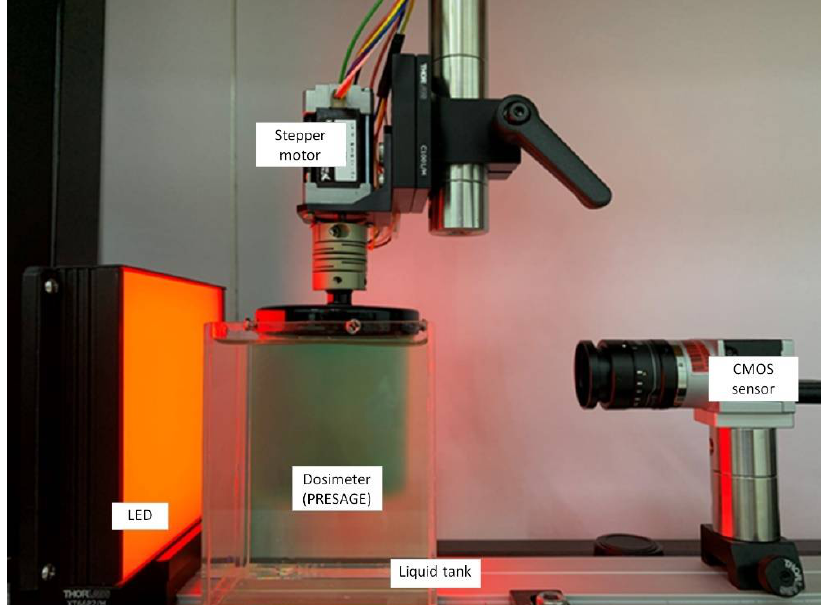
Figure 6. The in-house CMOS-OCT dosimetry system from the Laboratory of Medical Physics & Simulation, Universiti Teknologi MARA. The system primarily consists of CMOS sensor, the dosimeter, LED, and stepper motor.